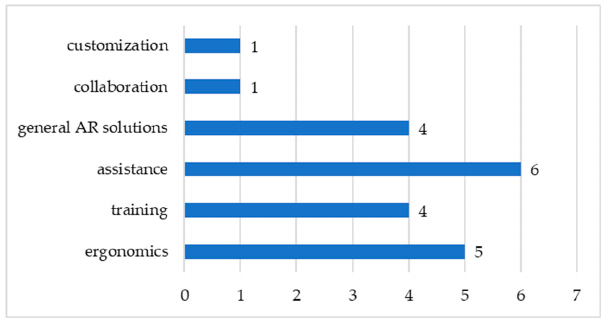
Figure 11. Distribution of papers referring to ‘other’ AR systems according to their purpose.